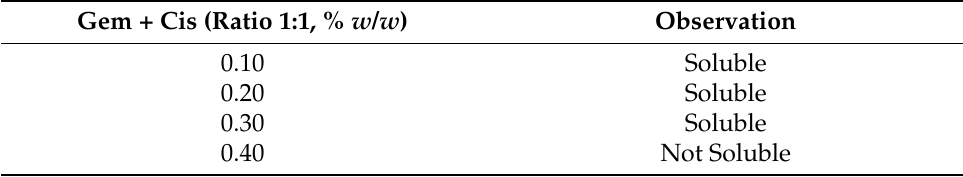
Table 2. Solubility of drug gemcitabine and cisplatin in NaCl solution (0.90% w / v ). Gem + Cis (Ratio 1:1, % w / w